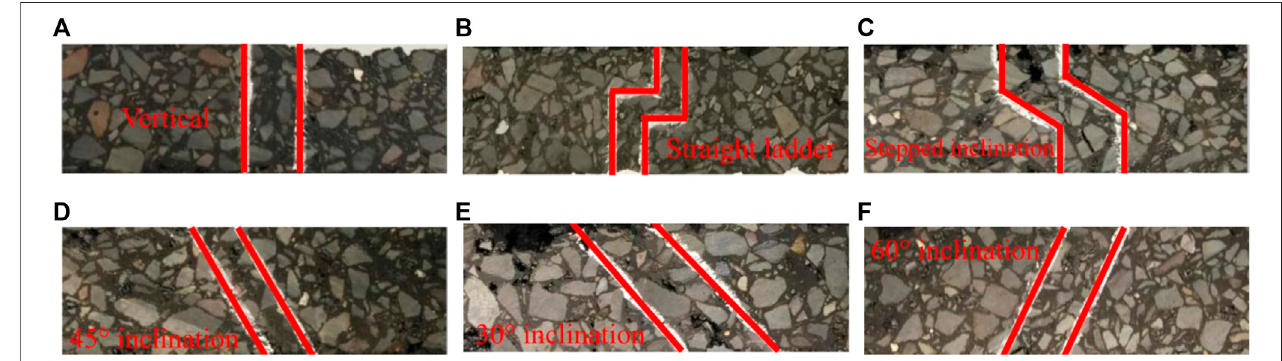
FIGURE 2 | Composite beam sections with different interface forms: (A) Type A; (B) Type B; (C) Type C; (D) Type D; (E) Type E; (F) Type F.